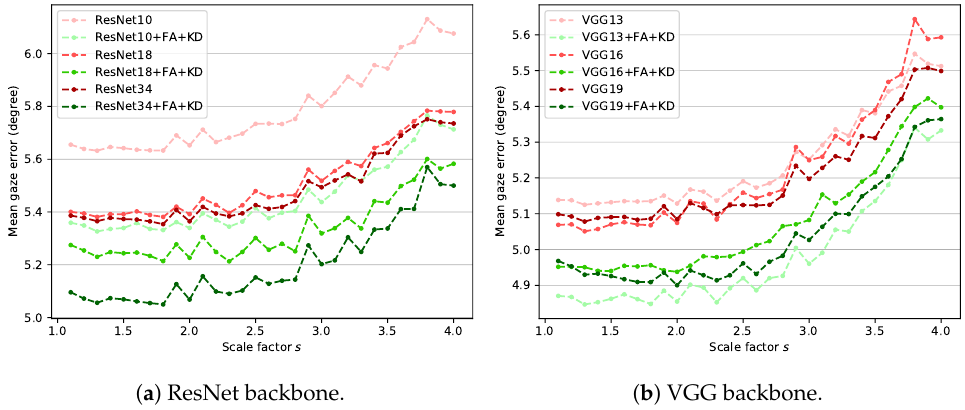
Figure 6. Mean gaze error on MPII dataset with different backbones: ( a ) ResNet and ( b )